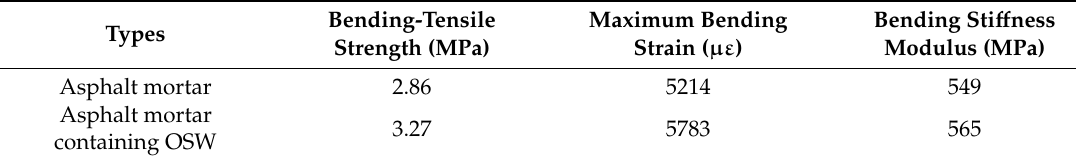
Table 6. Beam bending test results of two asphalt